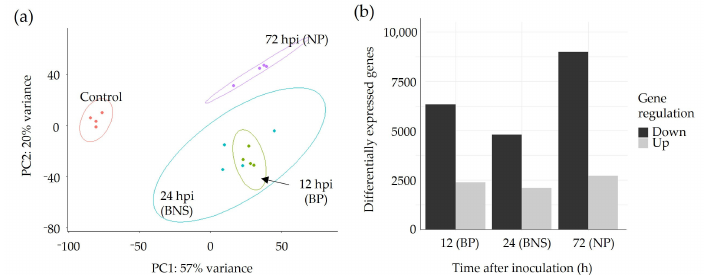
Figure 3. Genome-wide evaluation of RNA-sequencing data in chickpea var. ‘Sonali’ roots un- dergoing colonisation by Phytophthora medicaginis . ( a ) Principal component analysis of RNA-seq samples at 12, 24 and 72 h post-inoculation (hpi), and mock-inoculated control. ( b ) Number of significantly up-regulated and down-regulated genes in chickpea var. ‘Sonali’ roots at 12, 24 and 72 hpi ( p < 0.05, 1 < log2FC > − 1). BP: biotrophic phase, BNS: biotrophy to necrotrophy switch and NP: necrotrophic